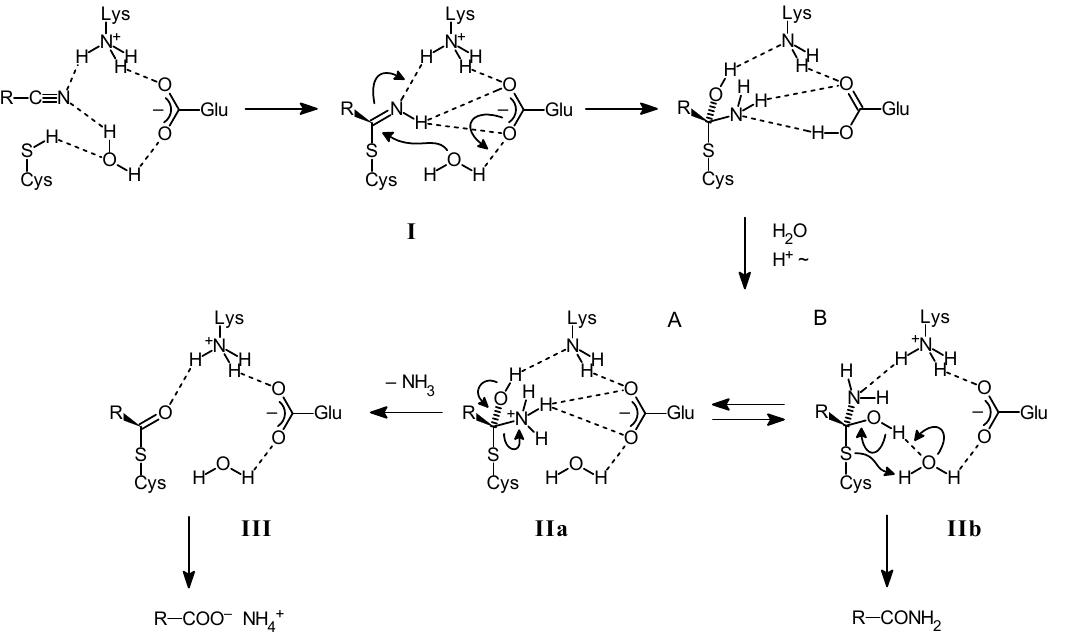
Figure 2. Proposed reaction scheme for the conversion of nitriles to acids or amides by nitrilases [21]. This hypothetical reaction scheme suggests that the acids or the amides can be alternatively formed from the tetrahedral intermediate in which the substrate is covalently bound to the catalytically active cysteine residue of the enzyme (IIa, IIb in Figure 2). In the proposed mechanism the formation of the amides formally occurs by a thiol elimination of the active cysteine residue and the acids are